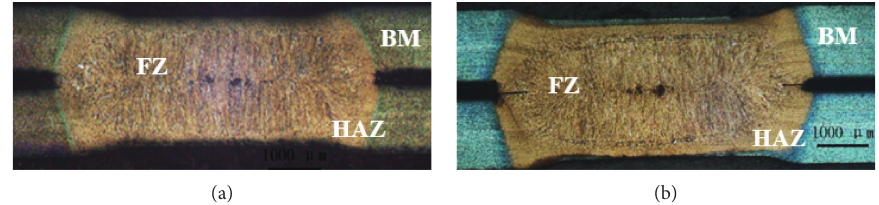
Figure 5: Microstructure of spot welding zone. (a) QP980 steel RSW; (b) TRIP800 steel RSW.